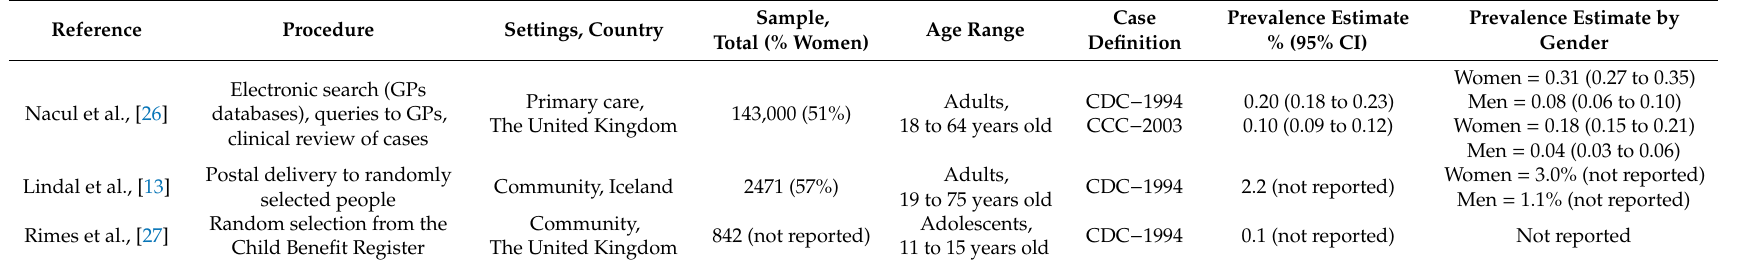
Table 1. Characteristics of the included studies reporting point prevalence of ME / CFS in European countries.